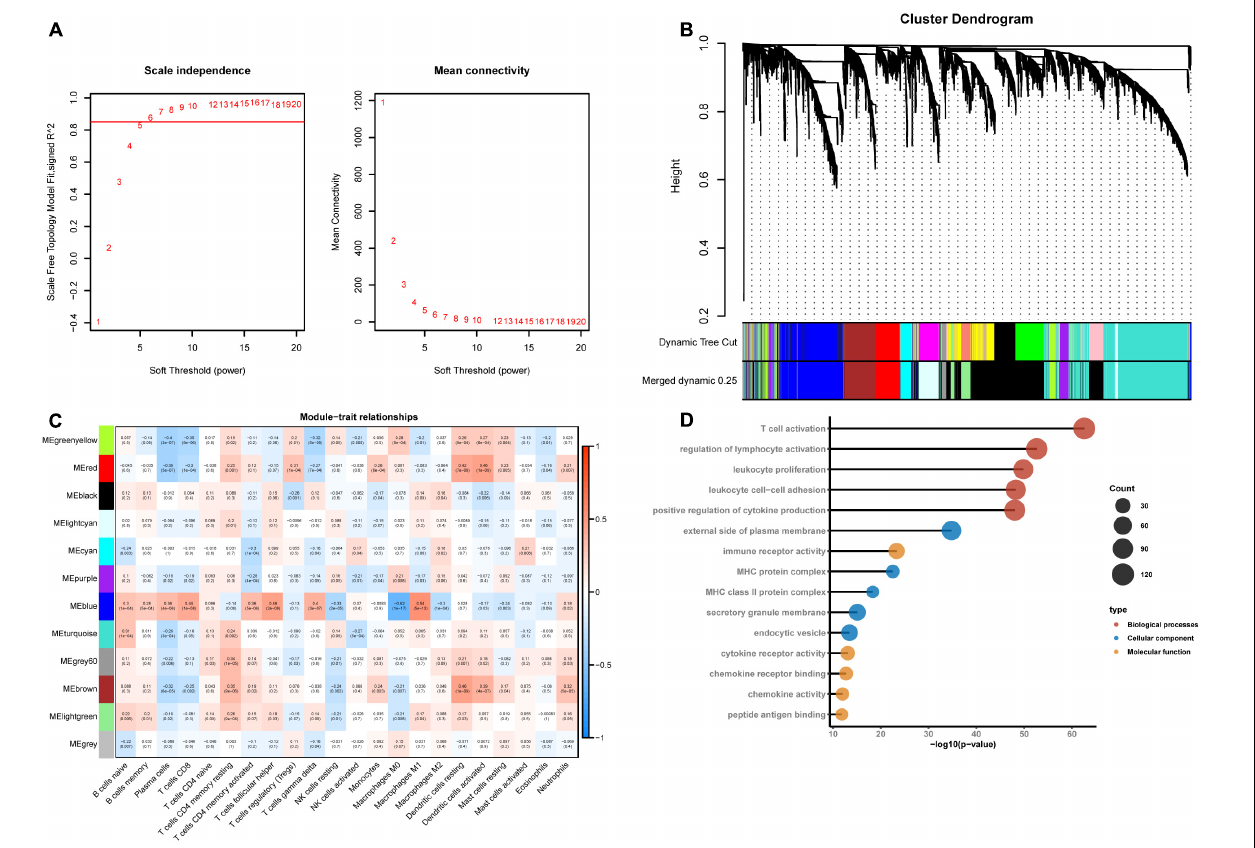
FIGURE 2 | Construction of a weighted gene co-expression network. (A) Analysis of the scale-free network coefficient R-squared for the soft threshold ( β ) and the mean connectivity for the soft threshold. We hope that the value of R-squared exceeds 0.85, so the power value is 6 ( β = 6). (B) A cluster dendrogram was built based on the dissimilarity of the topological overlap, which presents 12 network modules. (C) Heatmap demonstrating the correlation between module eigengenes and immune cells. (D) GO enrichment analysis of all genes in the hub module.